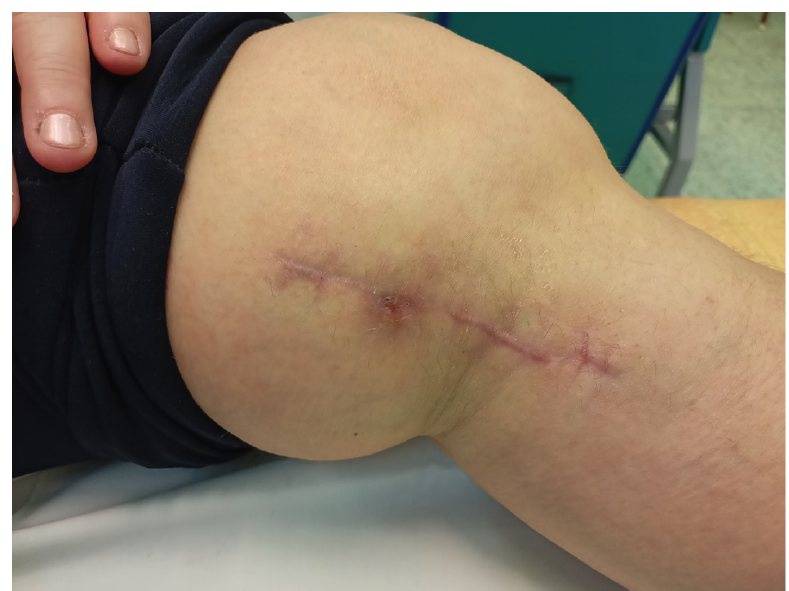
Figure 4. The local state of the wound after the end of topical ozone therapy procedures (total of 20 procedures within 6 weeks from the start of treatment). At the end of the 6-week therapeutic cycle, the pain previously reported by the patient was completely relieved (0 points in the VAS scale), while the quality of life determined in the subjective EuroQol scale was assessed by the patient at 90 points. During treatment, the patient did not report any side-effects of the therapy. Two months after the end of treatment, complete wound healing was observed during a follow- up visit at the Physical Medicine Ward (Figure